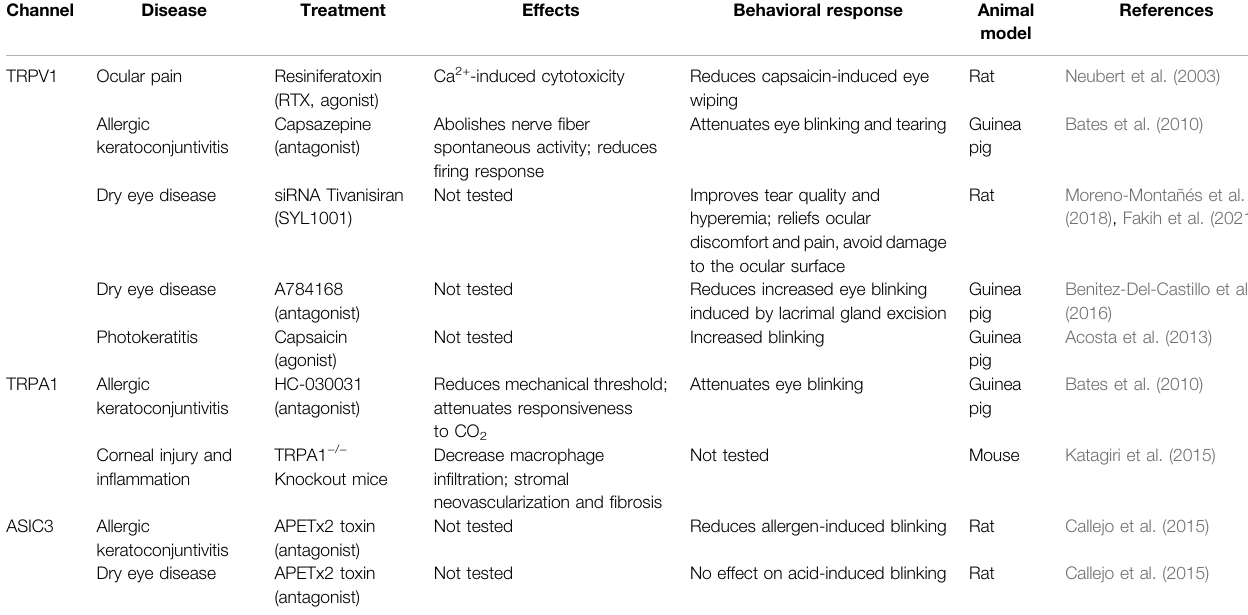
TABLE 1 | Proton-sensing ion channels involved in ocular surface